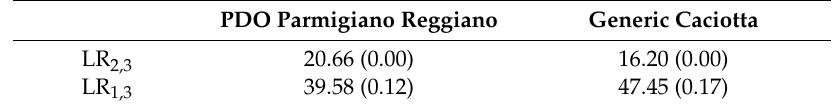
Table 6. Tests for non-linear adjustments.